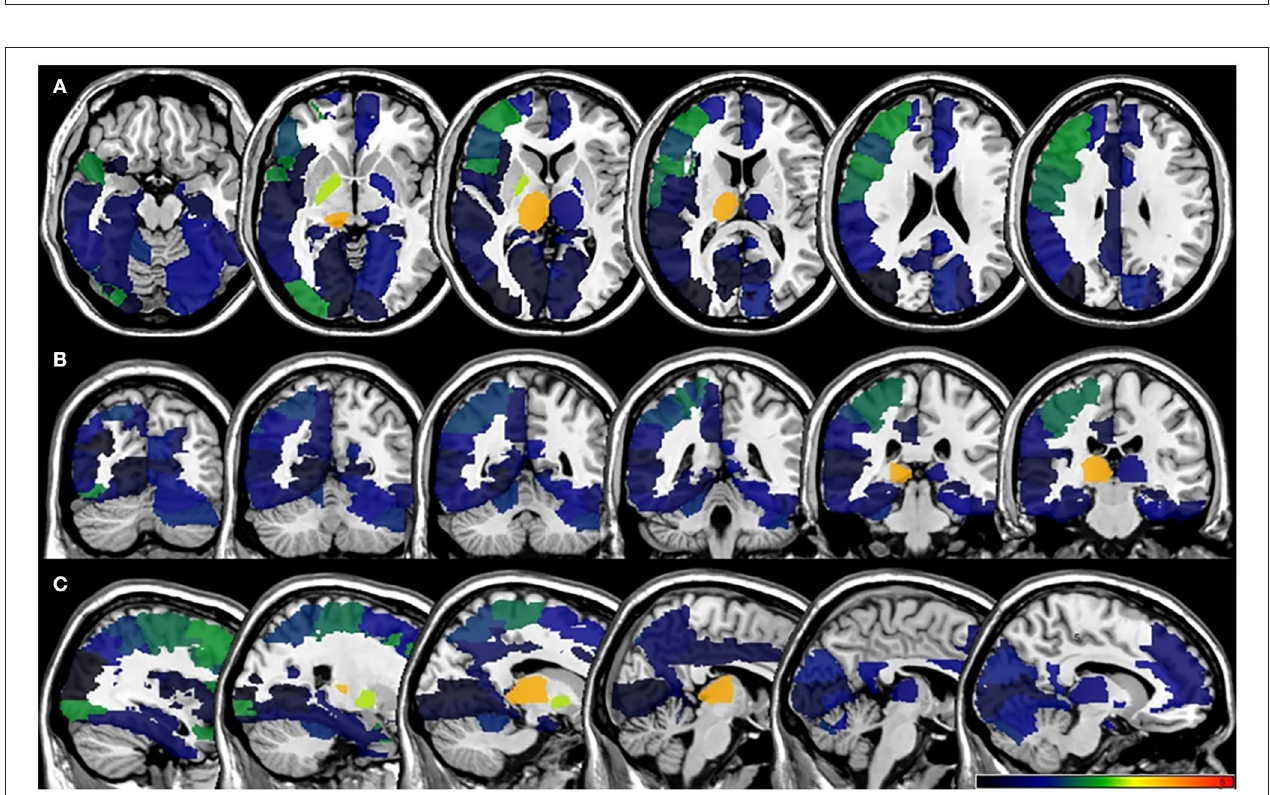
Frontiers in Aging Neuroscience |